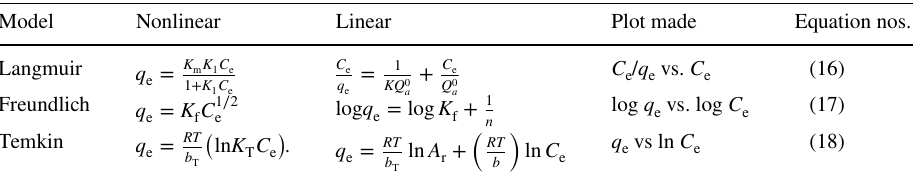
Fig. 12 Nonlinear isotherm plots at selected temperatures of: a 25 °C and b 45